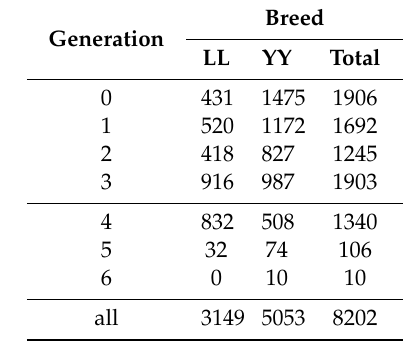
Table 1. Number of individuals by breed per generation (LL—Landrace, YY—Yorkshire).